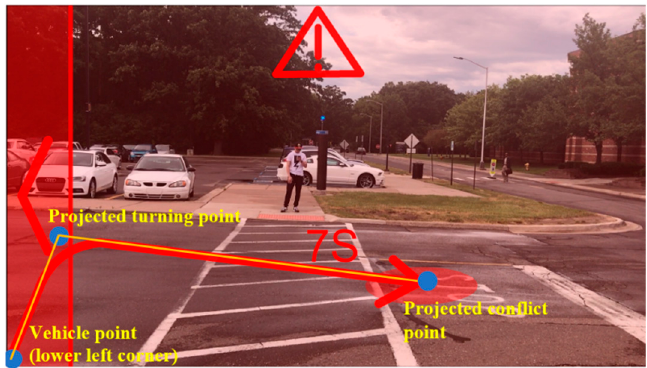
Figure 8. Example of scenario 2: Vehicle point could not be projected.